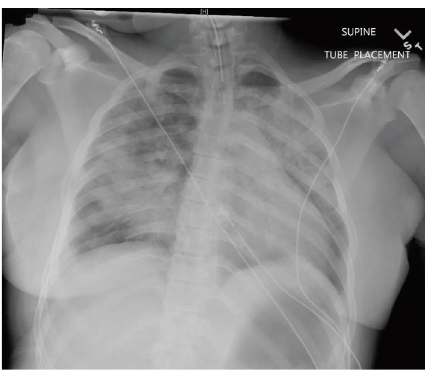
Figure 3: Postintubation chest X-ray showing worsening infltrates